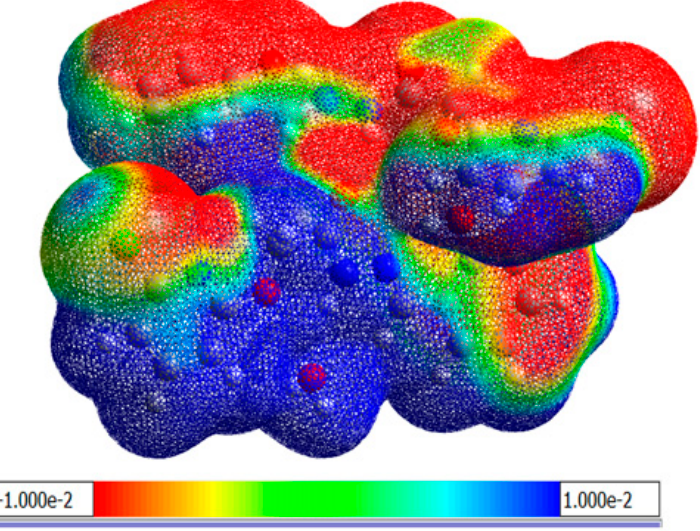
Figure 11. Molecular electrostatic potential and color scheme of HBPAH.